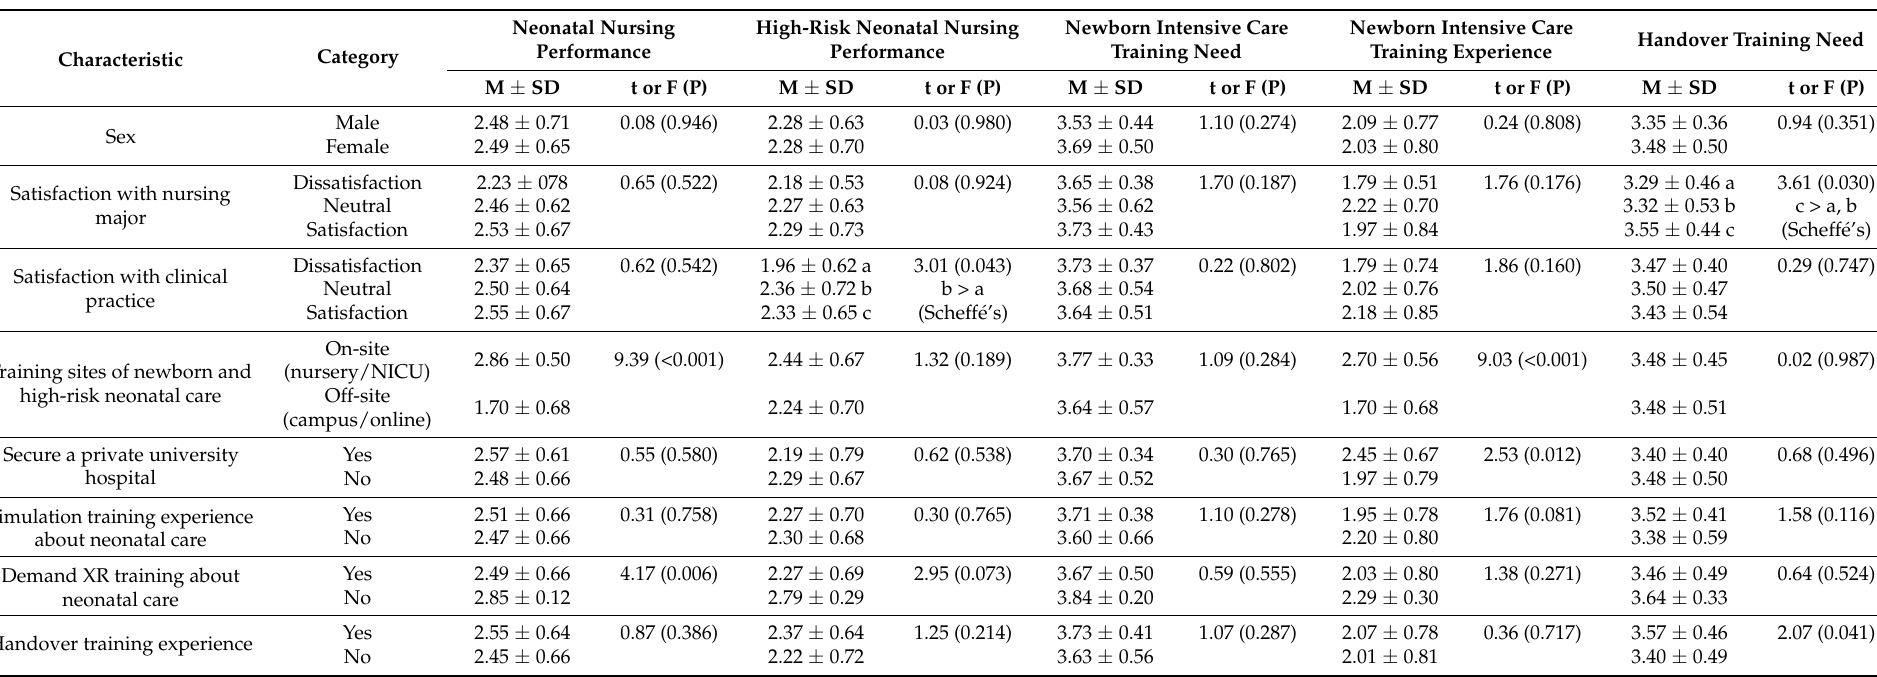
Table 2. Differences in neonatal and high-risk neonatal nursing performance, newborn intensive care training needs and experience, and handover training needs by general characteristics of participants ( n =